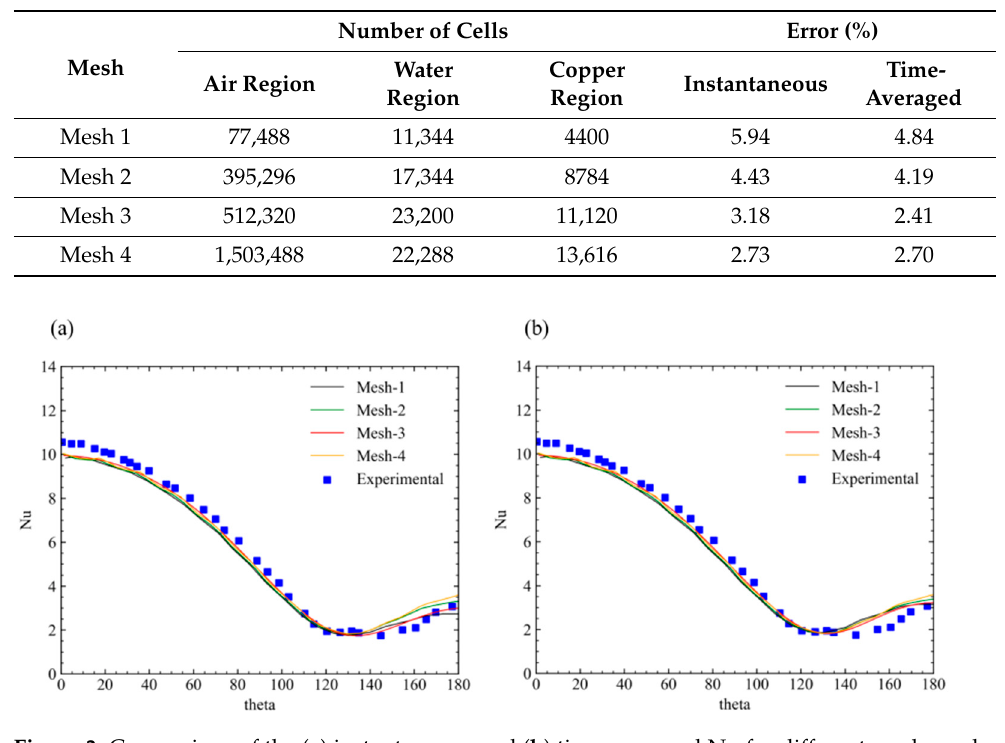
Figure 3. Comparison of the ( a ) instantaneous and ( b ) time-averaged Nu for different mesh resolu- tions with the experimental data.